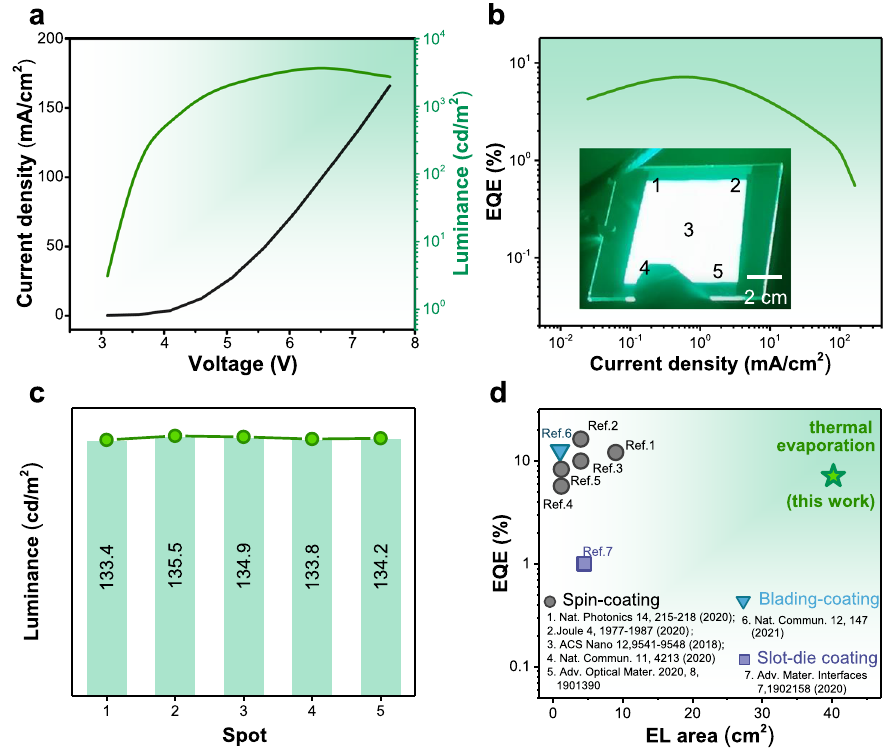
Fig. 5 The performance of large-area PeLEDs. a Current density-voltage-luminance curves. b EQE-current density curve. c The luminance of spots 1 – 5 (corresponding to the marked ones in panel b , inset) for our PeLED. d The reported EQE of large-area PeLEDs (exceed 1 cm 2 ) based on various